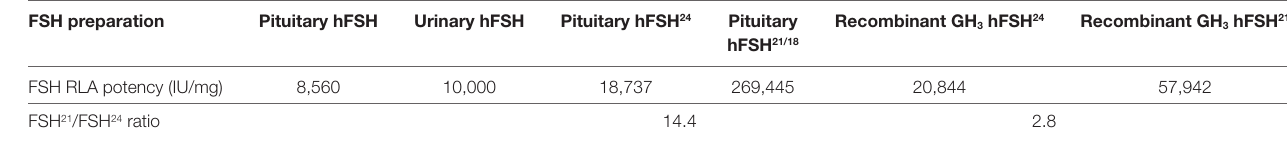
TABLe 2 | Follicle-stimulating hormone (FSH) receptor-binding activities of pituitary and recombinant hFSH glycoform